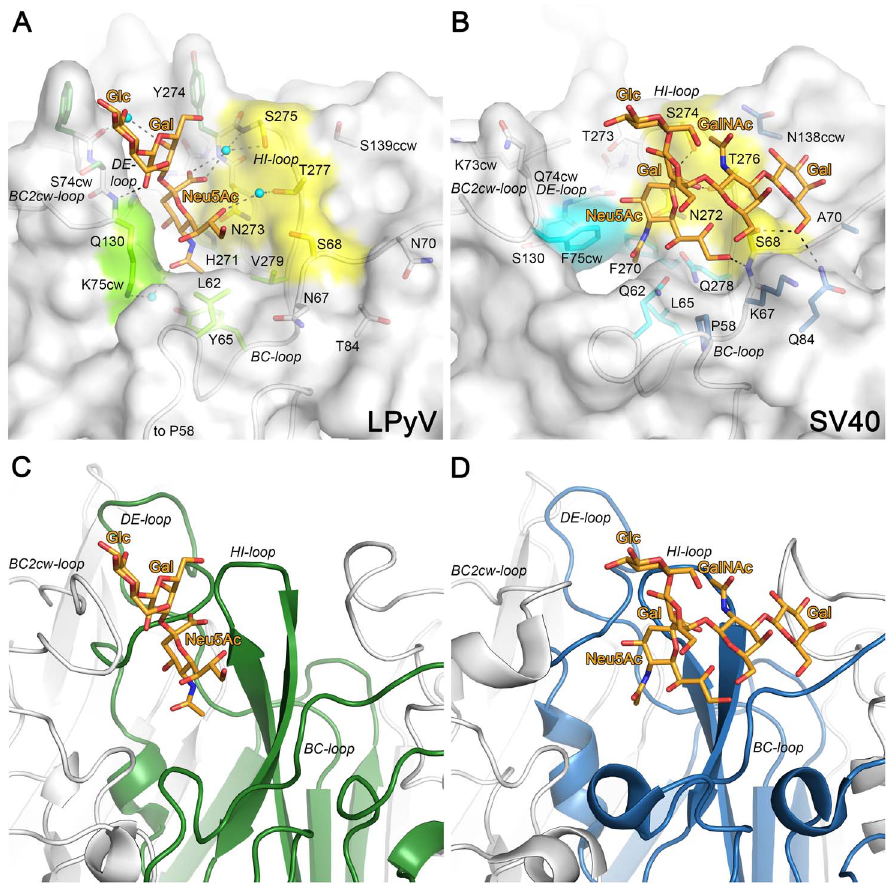
Figure 5. Comparison of oligosaccharide binding sites of LPyV and SV40. A & C. LPyV VP1 in complex with 3SL. B & D. SV40 VP1 in complex with GM1 pdb (3BWR). In panels A and B, the proteins are shown in surface representation, with the BC- and HI-loops also indicated in cartoon representation. Residues contributing to ligand binding or specificity are shown in stick representation. Receptor-binding residues that are identical between the two proteins are colored yellow in both panels, while residues that differ between the two proteins, but reside on the same location on the VP1 surface, are colored bright green for LPyV and cyan for SV40. Residues that make additional contacts with the oligosaccharide only in one complex are colored dark green for LPyV and dark blue for SV40. Their non-binding counterparts in the other complex are colored white. The carbohydrate ligands are shown as orange sticks. Hydrogen bonds and water-mediated hydrogen bonds are shown as black and grey dashes, respectively. In panels C and D, the proteins are shown in ribbon presentation, with one monomer highlighted in green for LPyV and blue for SV40 VP1, respectively.